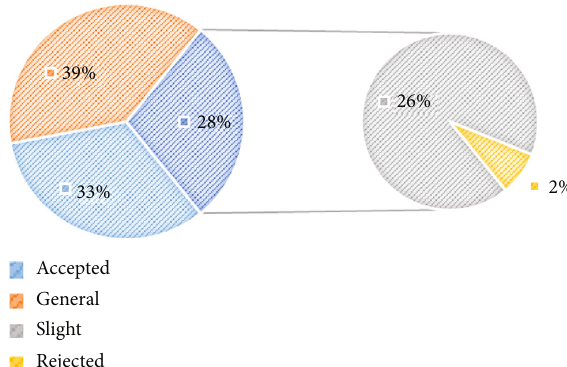
Figure 1: People ’ s recognition of video big data analysis